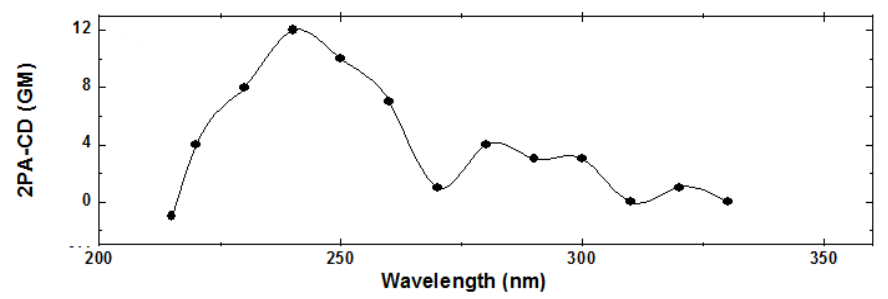
Figure 9. TPACD spectrum of R -BINOL/THF.